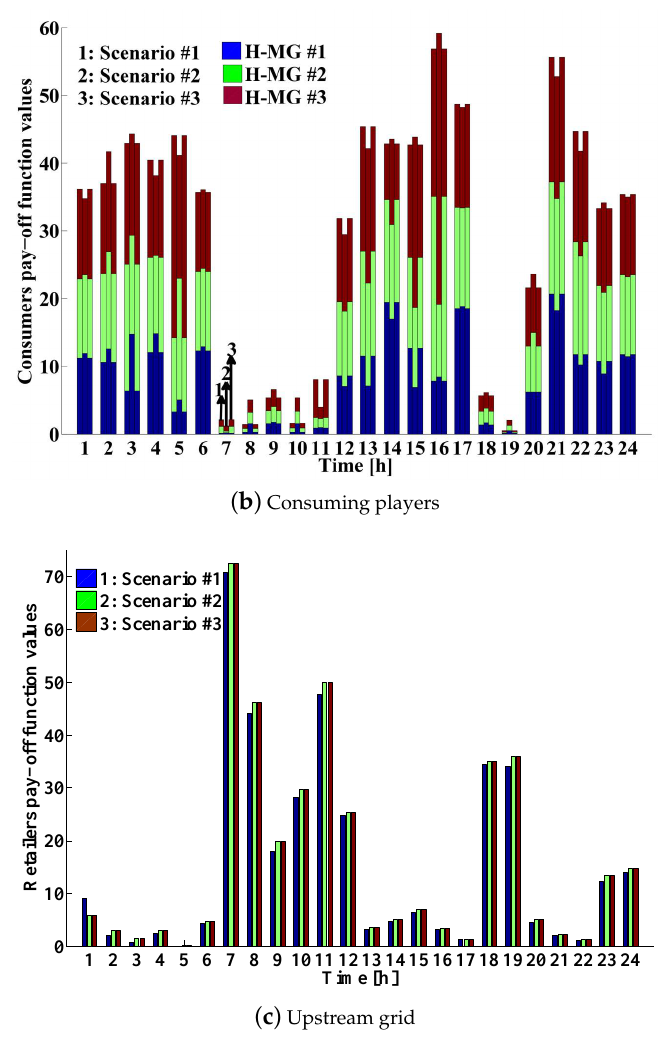
Figure 12. Pay-off function vs.